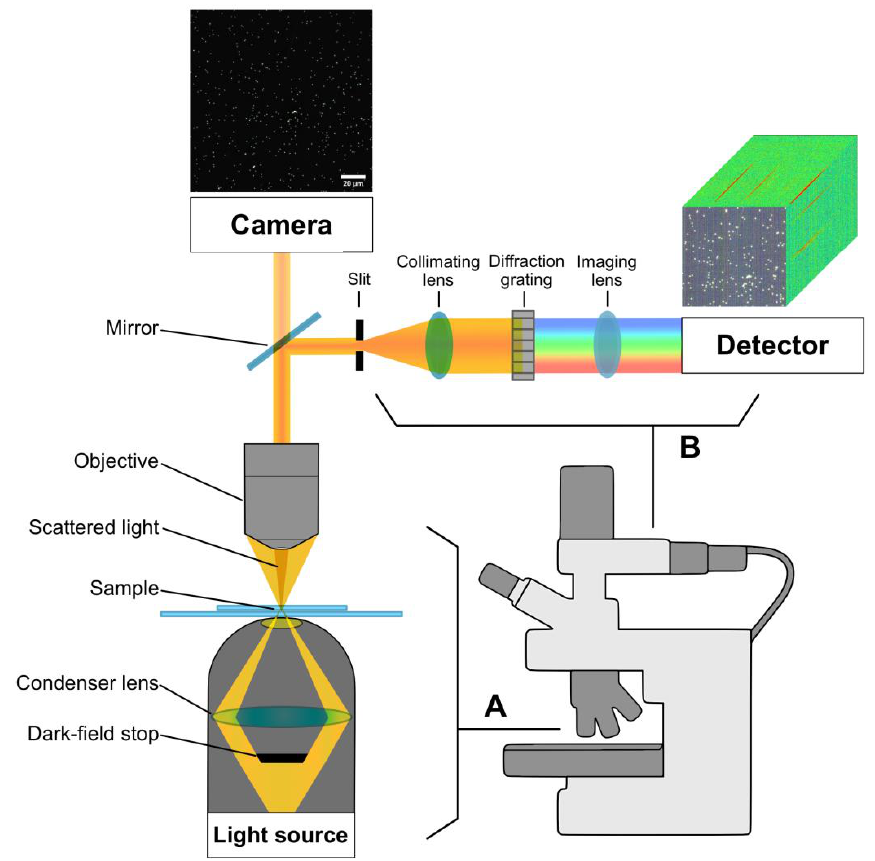
Figure 1. ( A ) Representative optical diagram of dark-field microscopy and ( B ) a scheme of spectral data cube acquisition on the example of 200 nm polystyrene nanoparticles.